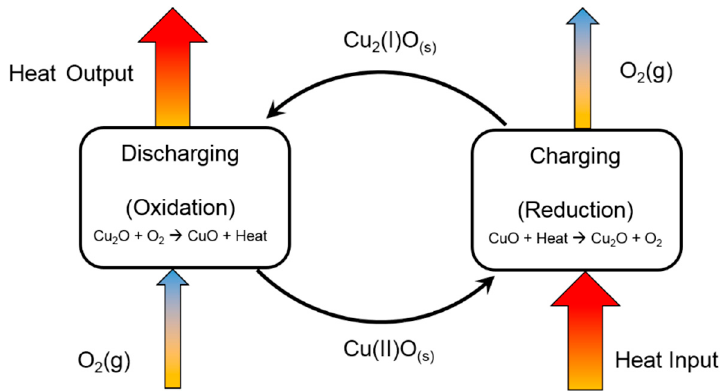
Figure 1. Thermochemical energy storage system for Cu 2 O/CuO.